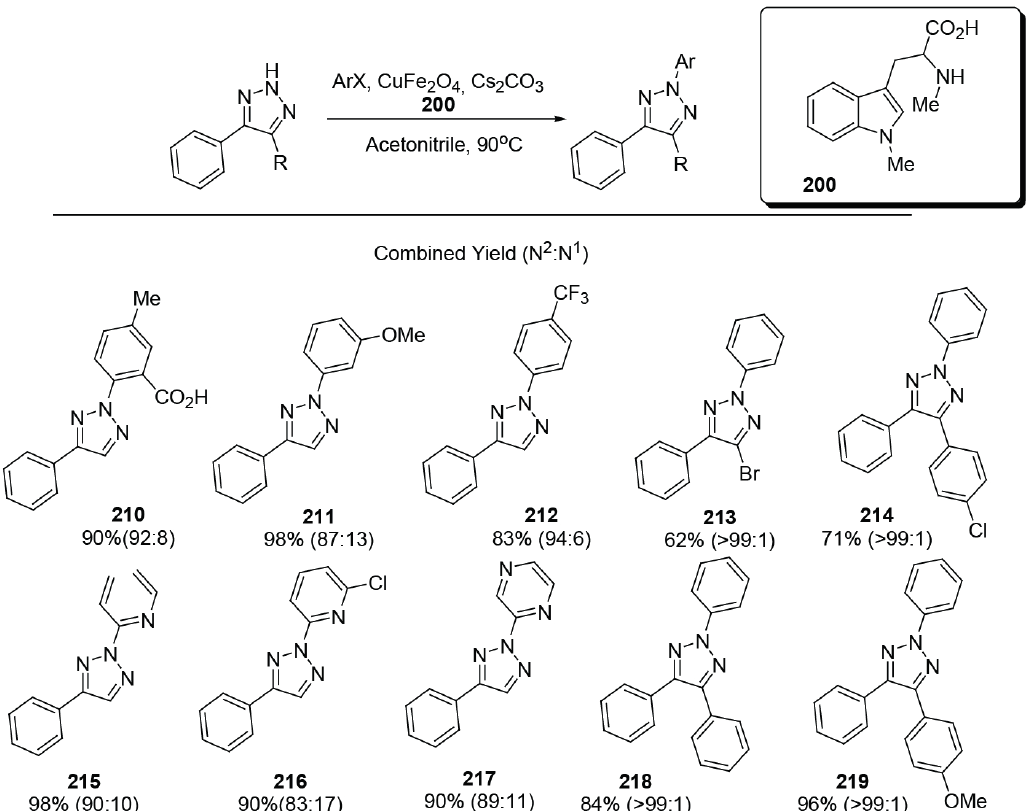
Figure 26 - Scope on the Copper catalyzed N 2 -Regioselective arylation of